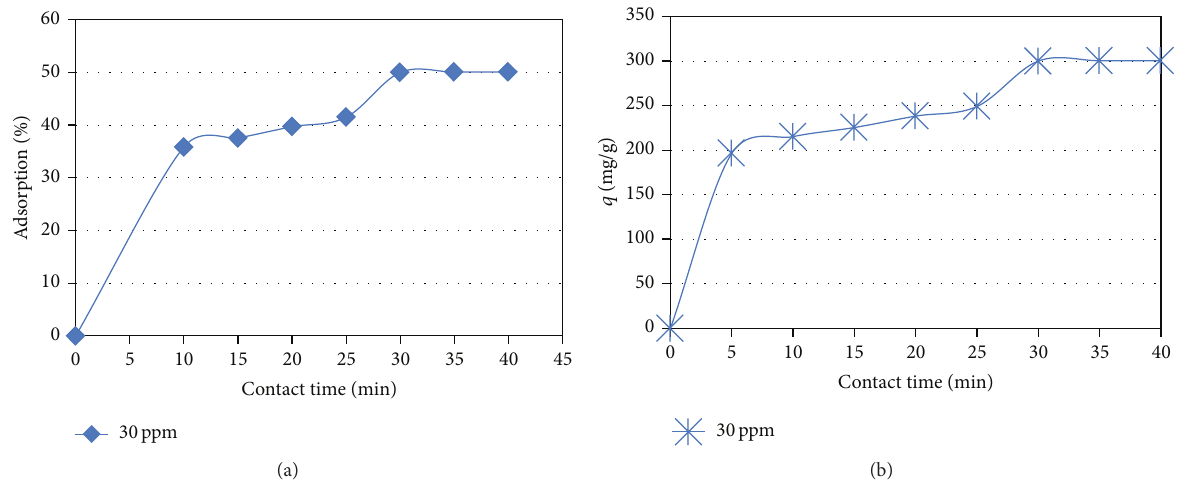
Figure 8: (a) Effect of contact time on methyl violet dye adsorption % (pH = 8.5, CNTs dosage = 50 mg/L). (b) Effect of contact time on methyl violet dye adsorption capacity (pH = 8.5, CNTs dosage = 50